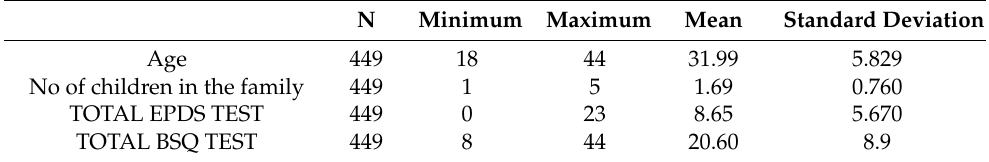
Table 1. Descriptive analysis of quantitative